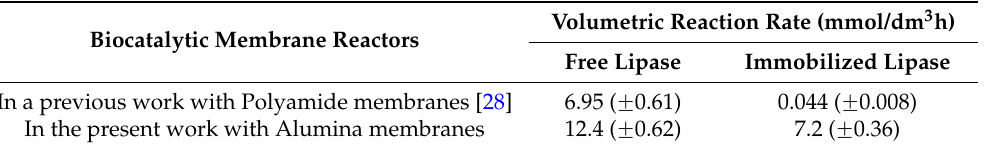
Table 3. Volumetric reaction rate resulting from the study about lipase immobilized with different approaches on different matrices.